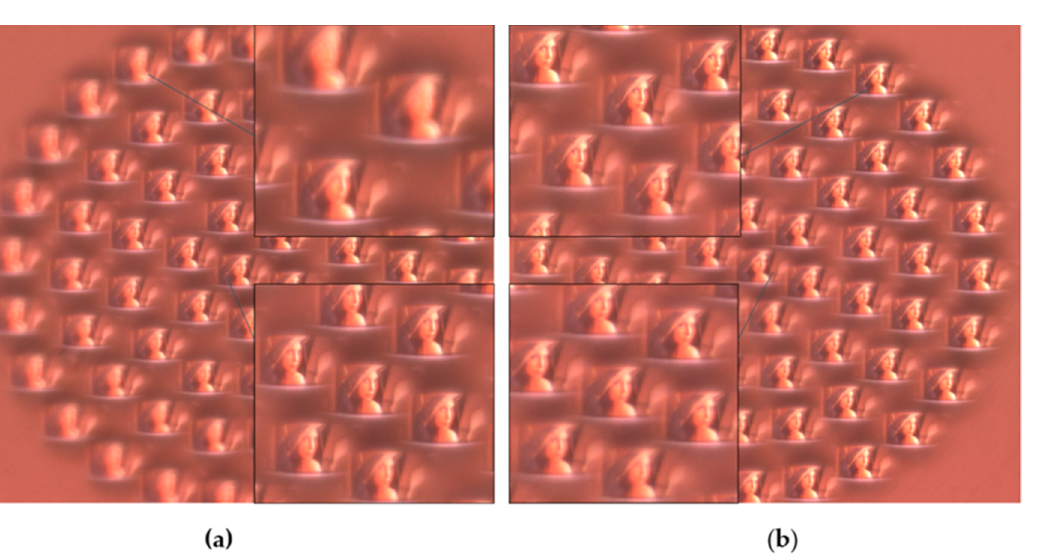
Figure 9. ( a ) The captured image when the central ommatidium is in focus; ( b ) the captured image when the flanking ommatidia are in focus.